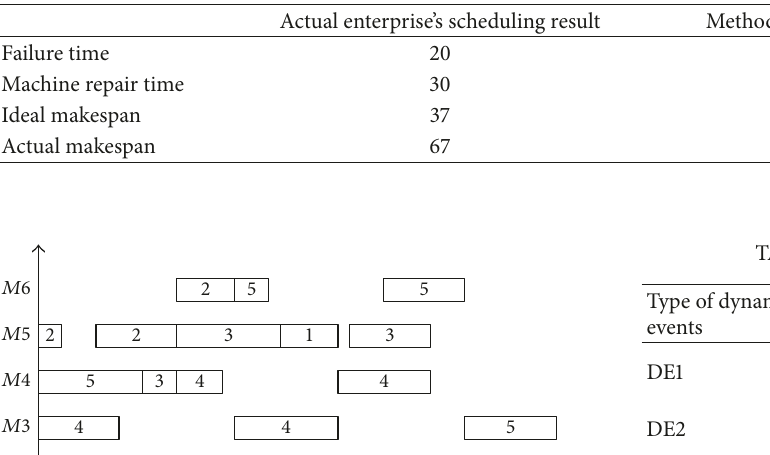
Table 6: Comparison results for rescheduling.